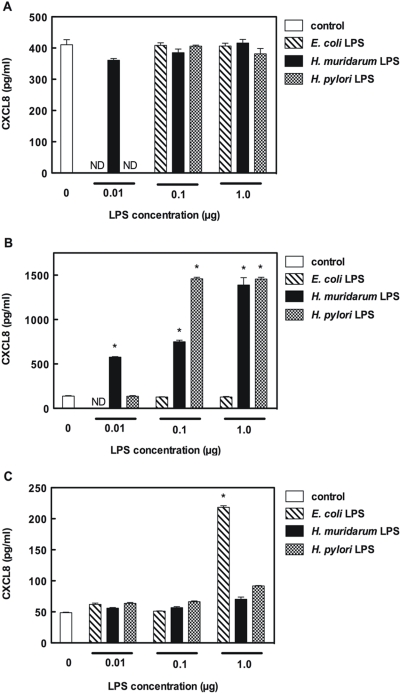

H. muridarum LPS is specifically recognized by TLR2.Normal HEK293 cells (A), as well as HEK293 cells stably expressing either TLR2 (B) or TLR4 (C), were either left untreated (control) or stimulated with highly purified LPS from E. coli 0111:B4, H. muridarum ATCC49282 or H. pylori NCTC11637. The levels of secreted CXCL8 were measured in culture supernatants at 24 h post-stimulation. Data correspond to the mean±SD (triplicate determinations) and are representative of two independent experiments. Statistical differences were observed between the CXCL8 responses of LPS-stimulated and control cells (*, P<0.0001).